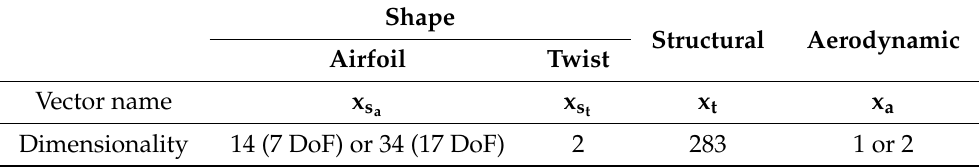
Table 5. Design variable designations for the different parameterizations.